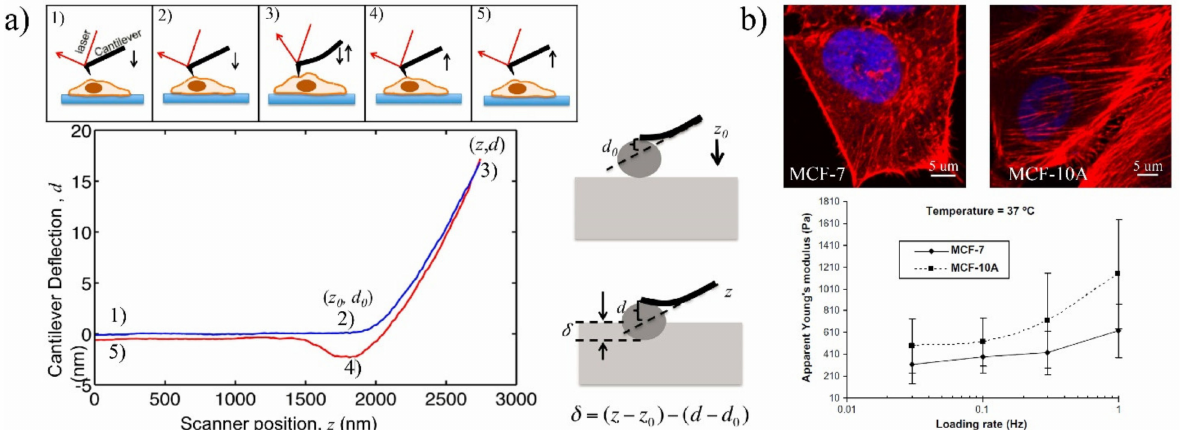
Figure 5. ( a ) AFM indentation and interpretation of the curve: ( 1 ) AFM above the cell surface, ( 2 ) AFM in contact with the cell surface, ( 3 ) motion of the AFM cantilever to contact the cell surface and indent into cell until the setpoint, ( 4 ) AFM tip detaching from the sample (AFM tip-cell adhesion), ( 5 ) returning to initial position. Reprinted with permission from [128]. Copyright Journal of Visualized Experiments 2013. ( b ) Cell elasticity measurement of human breast cancer cells with AFM and visualization of actin filaments in both cell lines. Reprinted with permission from [104]. Copyright Elsevier